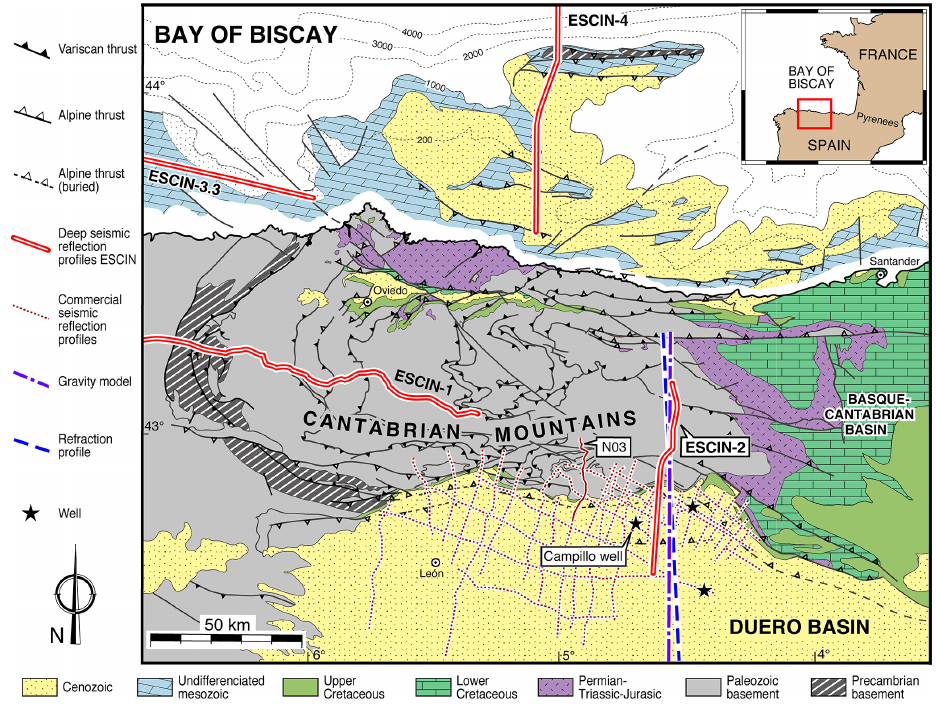
Figure 1. Simplified geological map of NW Iberia and its continental platform. Location of deep seismic reflection profile ESCIN-2 and the rest of the geophysical data mentioned in the